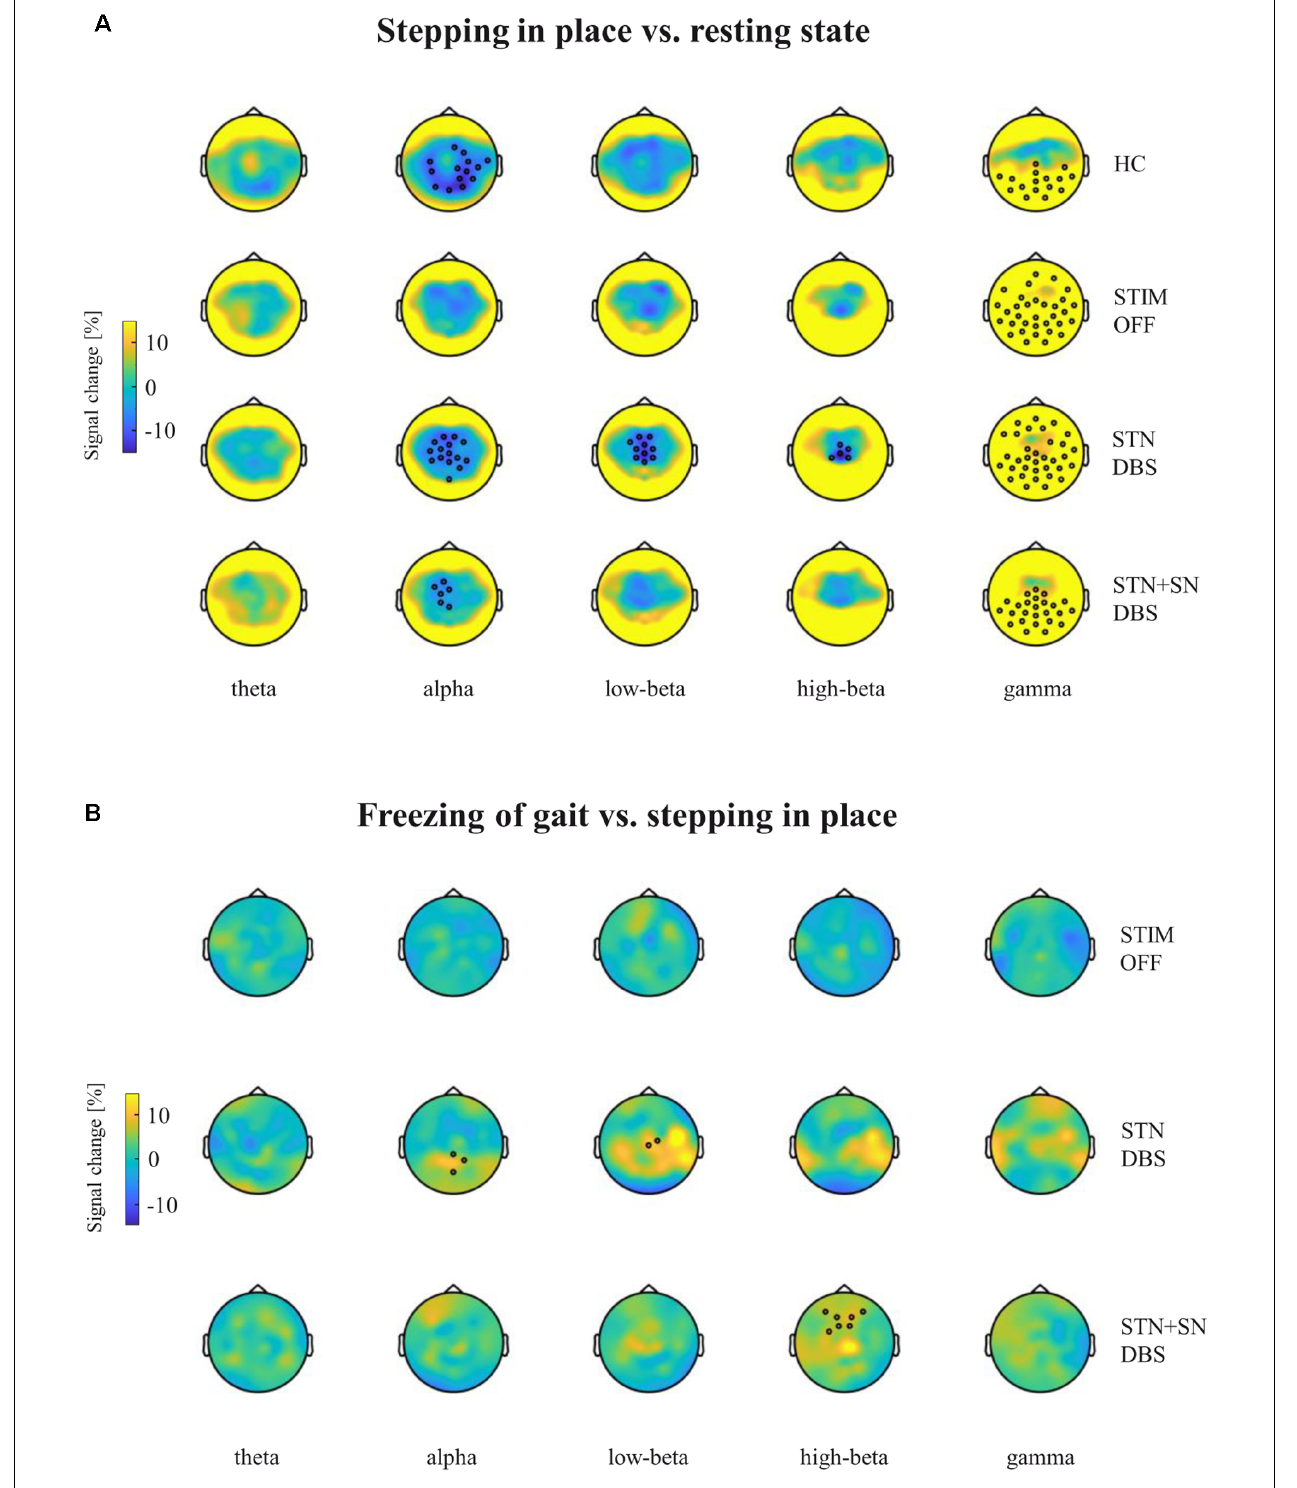
FIGURE 5 | Cortical activity modulation in response to different motor conditions. Topographic percentual power signal change is displayed for (A) stepping in place vs. resting-state and for (B) freezing episodes vs. unaffected stepping in place. The comparisons are represented for healthy control persons and for PD patients in the STIM OFF, STN DBS, and STN+SN DBS conditions (rows) separated into five frequency bands (columns). Black circles represent significant clusters of EEG sensors showing significant signal changes between motor conditions based on cluster-based permutation tests.